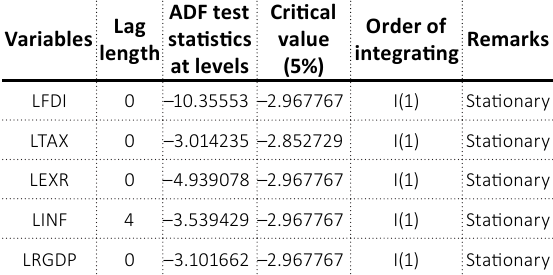
Table 1. Unit root